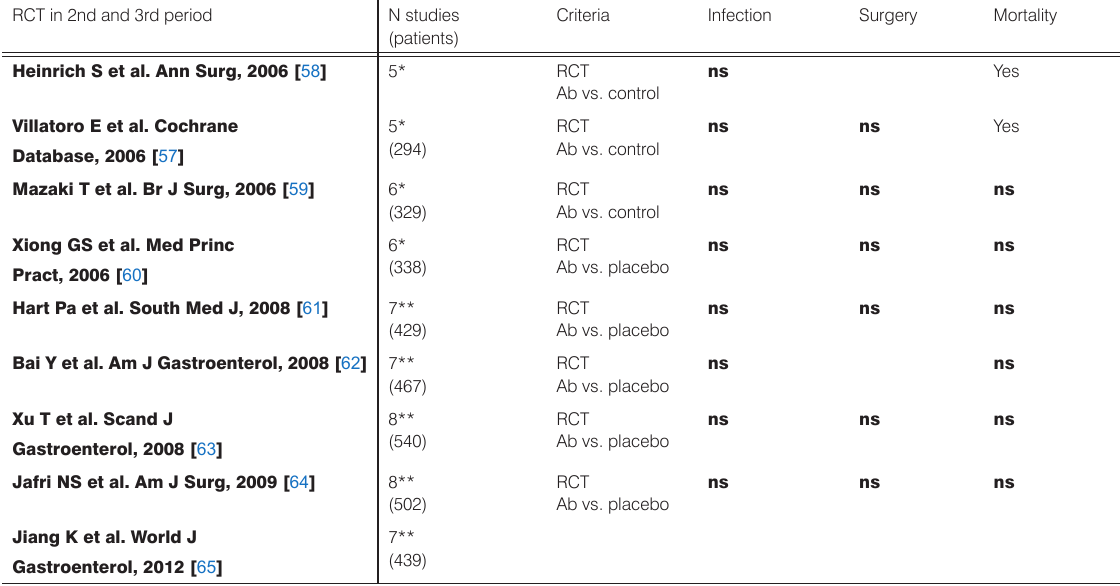
Table 6. Meta-analyses of RCT in 2nd and 3rd period.[53, 56-62] RCT in 2nd and 3rd period